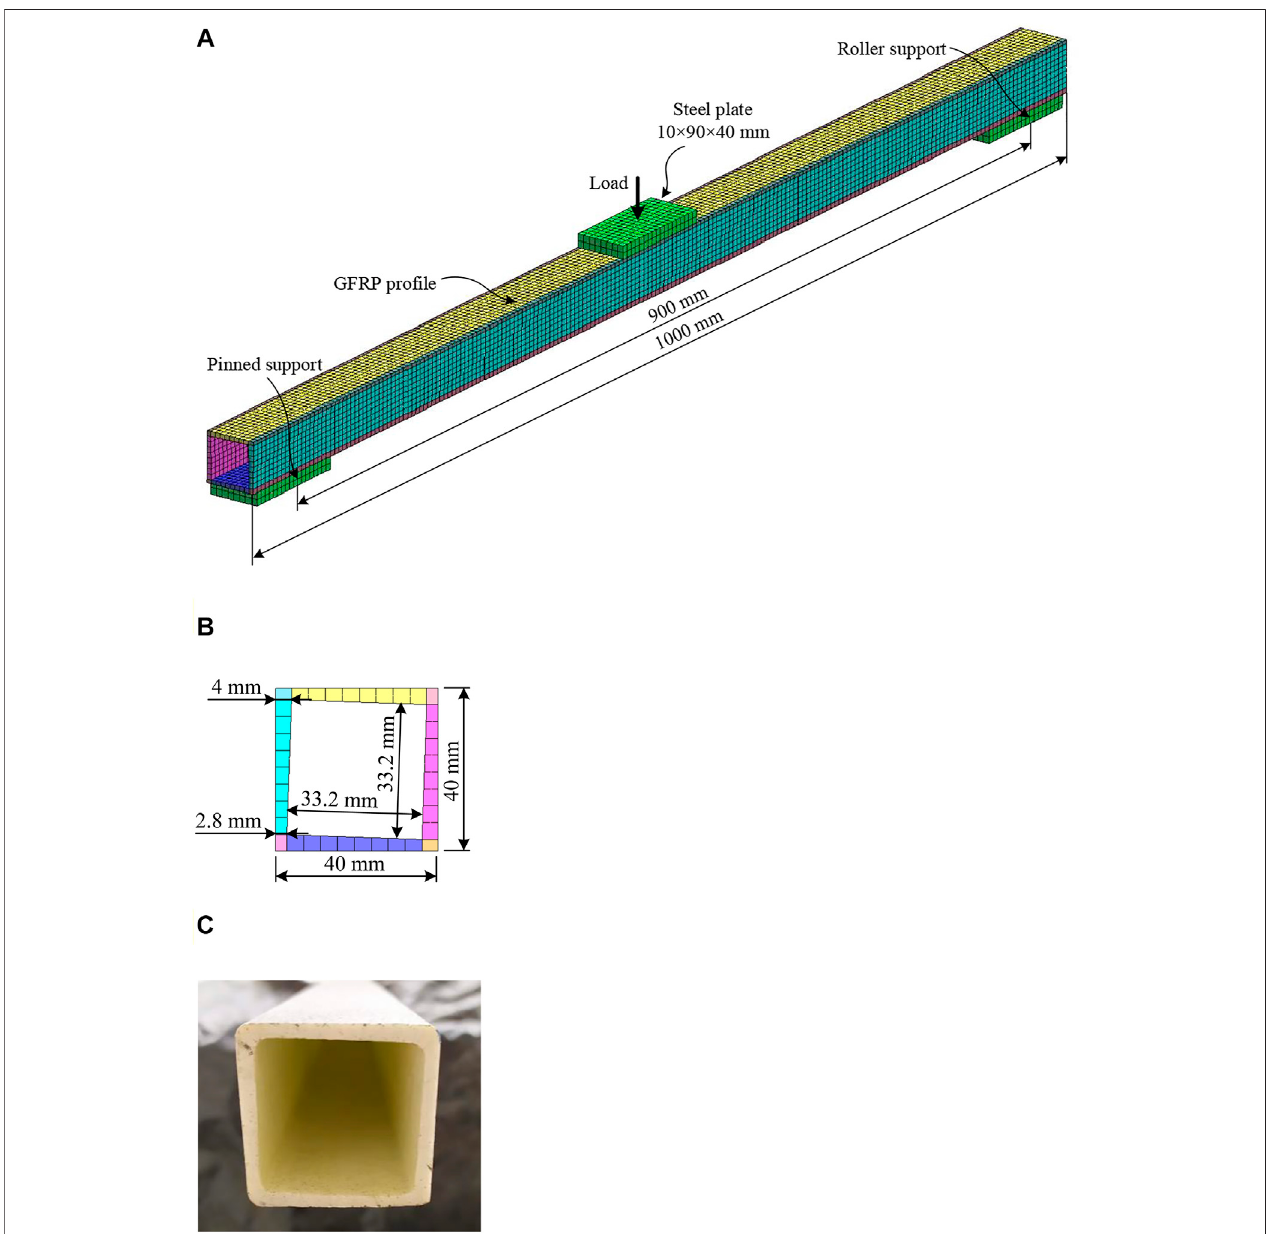
FIGURE 12 | Flexural U GIRA pro fi le: (A) FE model; (B) The modeled cross-section; (C) Actual cross-section imperfection.